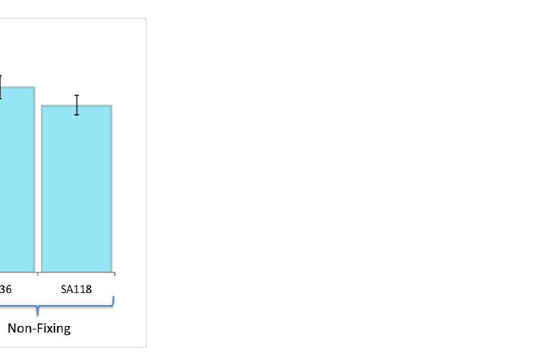
Fig 2. Differencesin shoot dry weight (per plant) between SA36 and SA118 grown under nitrogen fixing and non-fixing conditions.